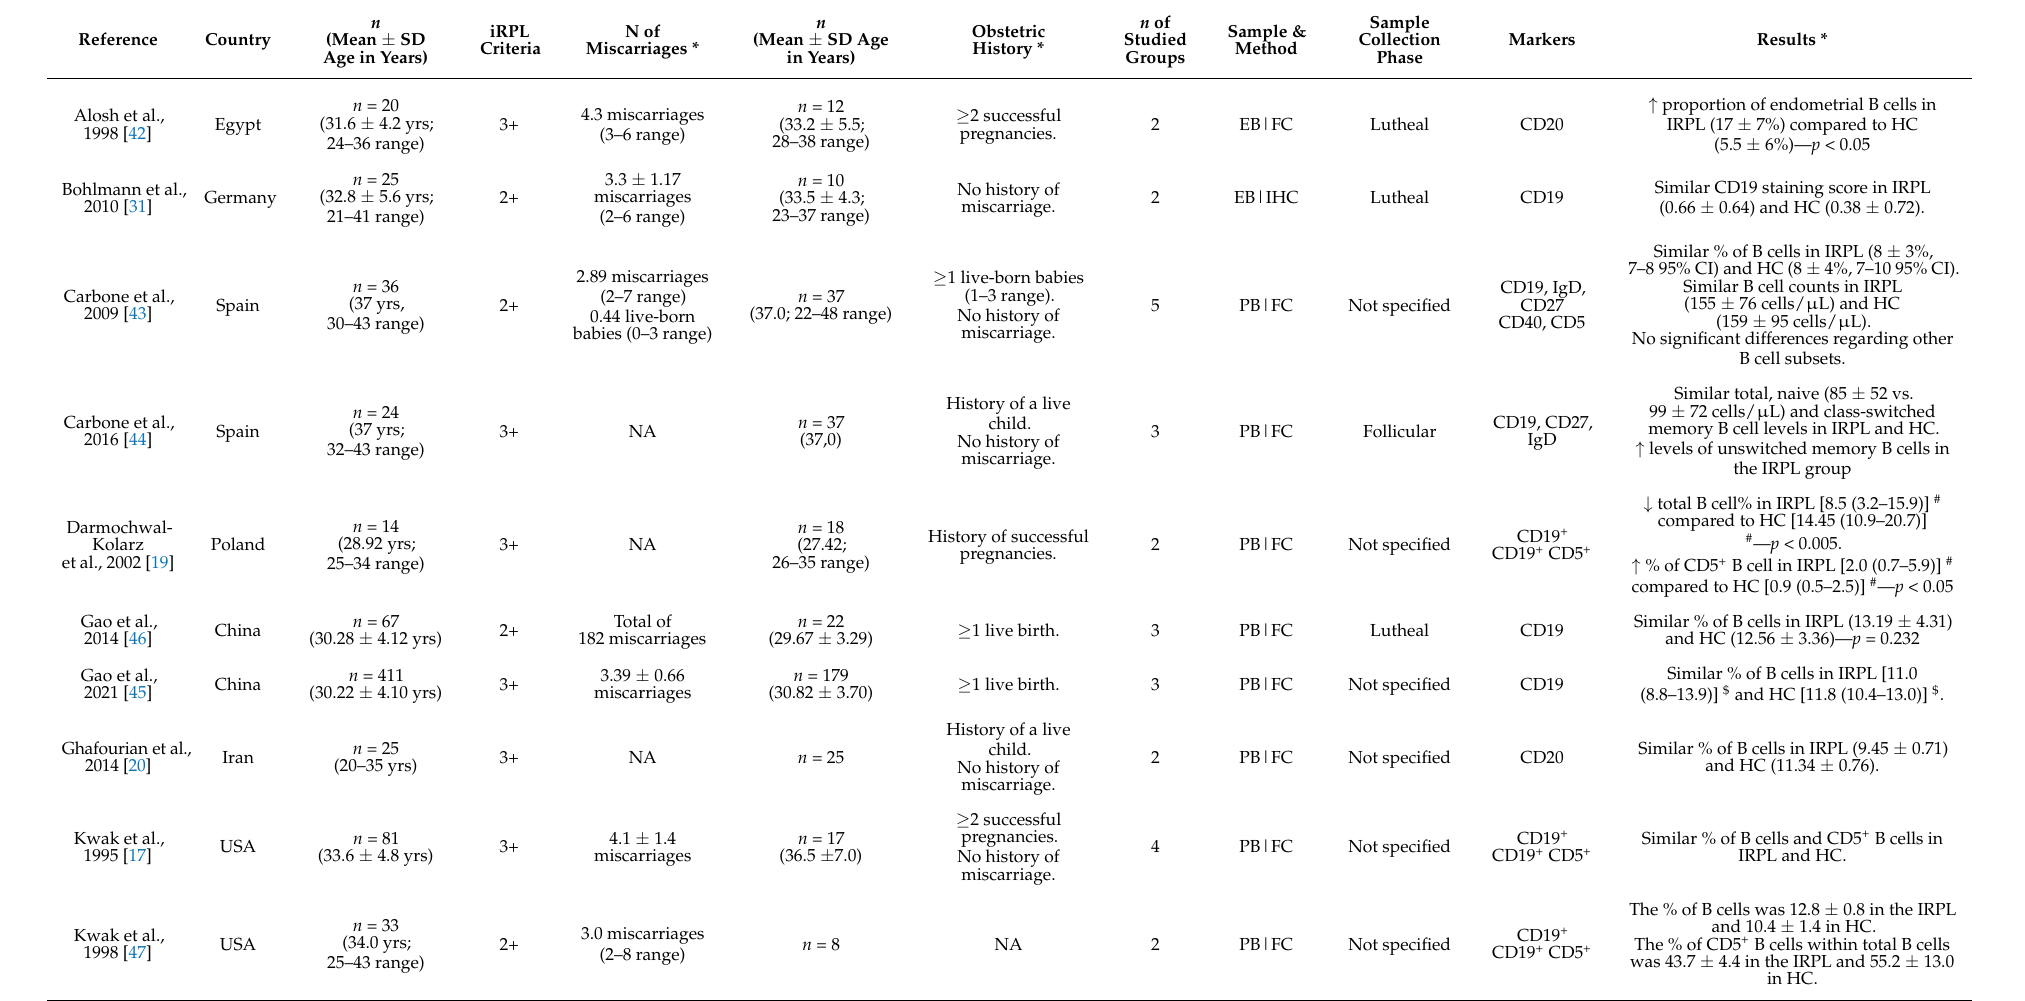
Table 2. Characteristics of included